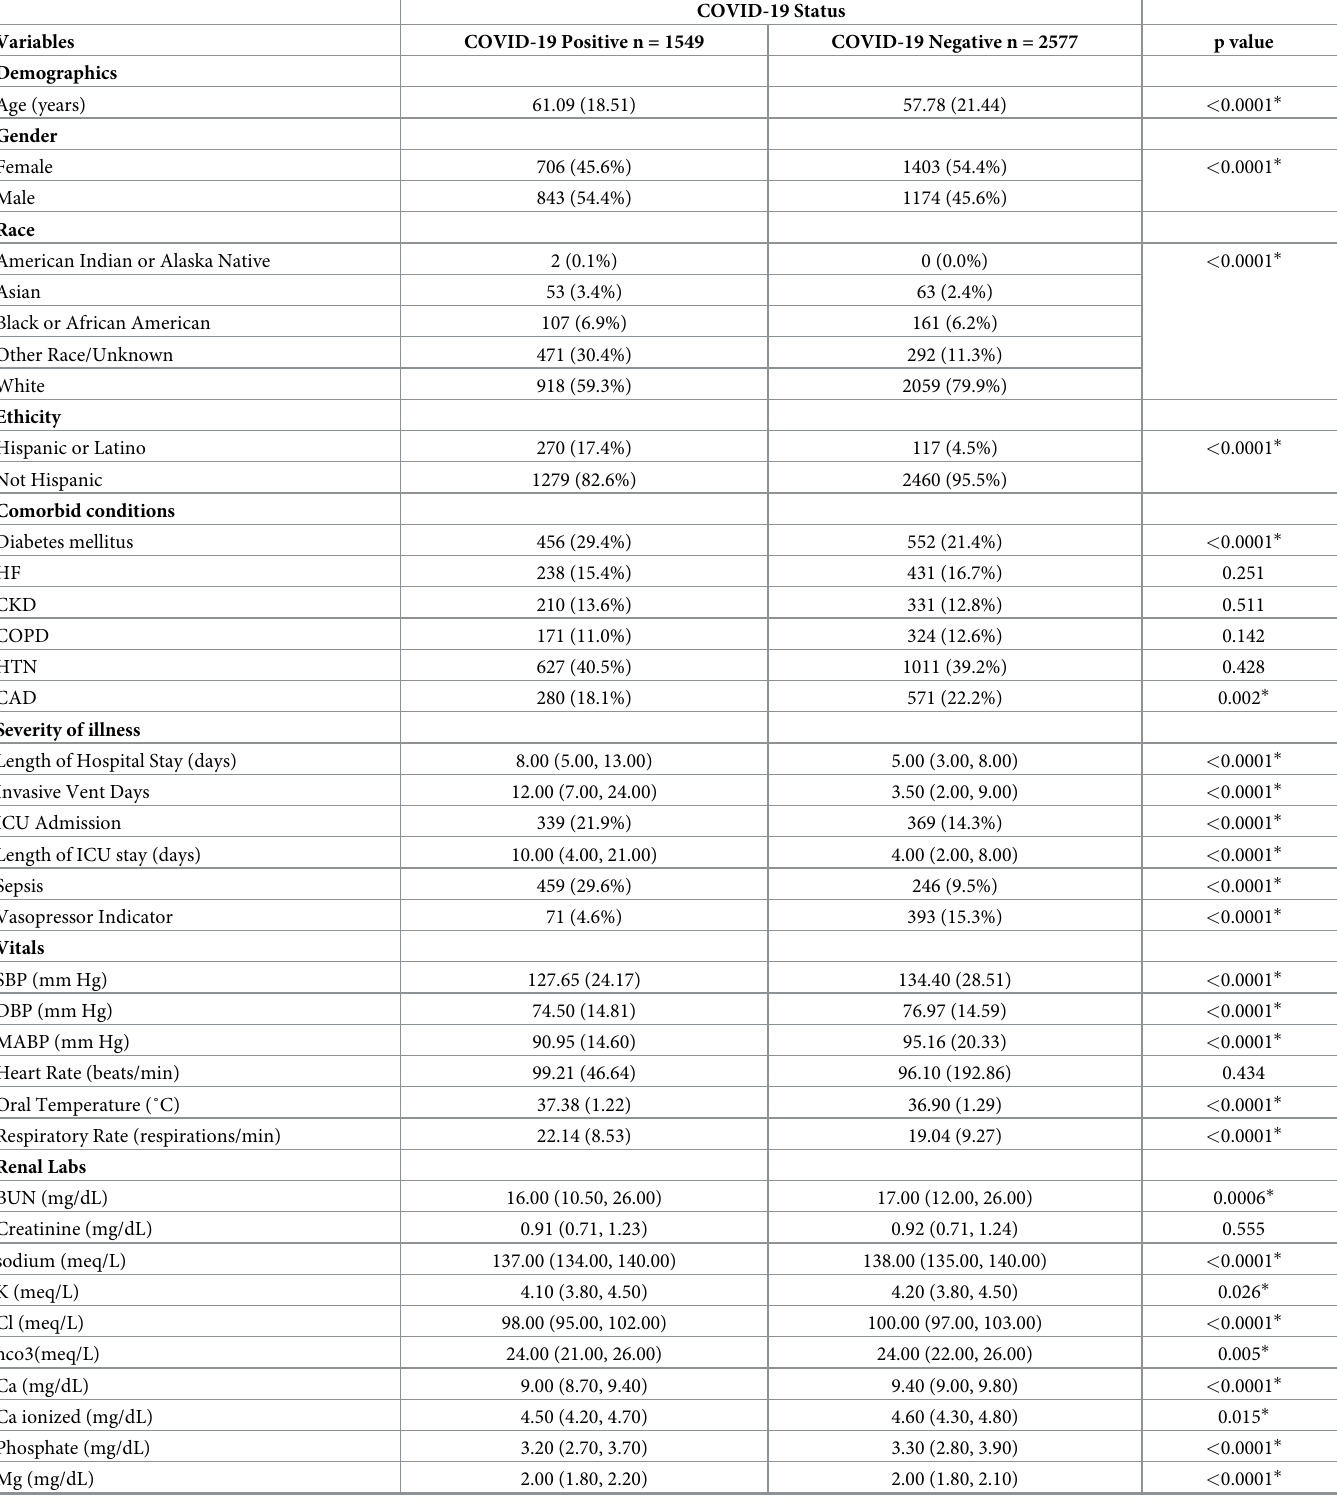
Table 1. Comparison of hospitalized COVID-19 positive and negative